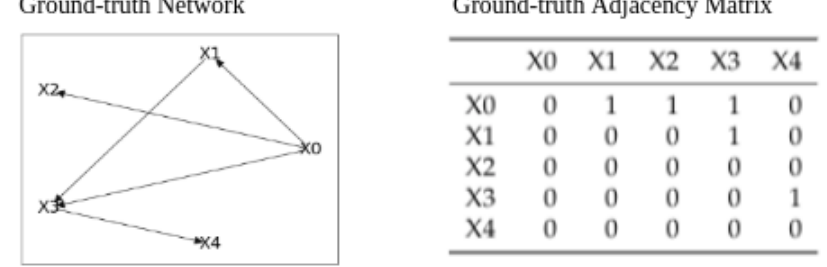
Figure 7. Ground truth network ( left ) and corresponding ground truth adjacency matrix ( right ). We generated a collection of synthetic data sets from the ground-truth and compared the causal inference methods of Bayes networks and Granger causality over